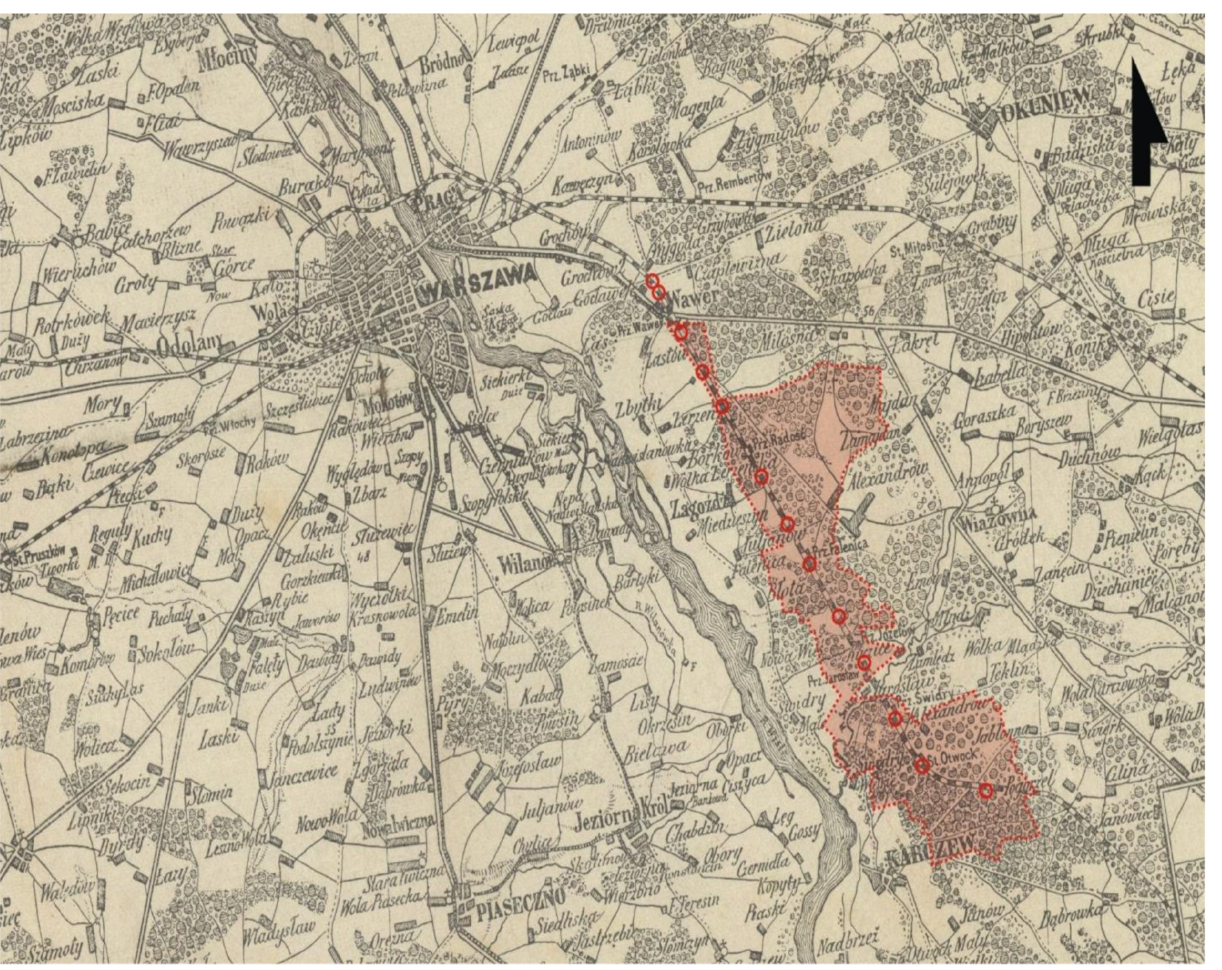
Figure 2. A map of summer resorts near Warsaw from 1905 with a railway network. Red dots mark historical railway stations, and a red dotted line demarcates the area of former summer resorts on the Otwock Line, by M. G ó